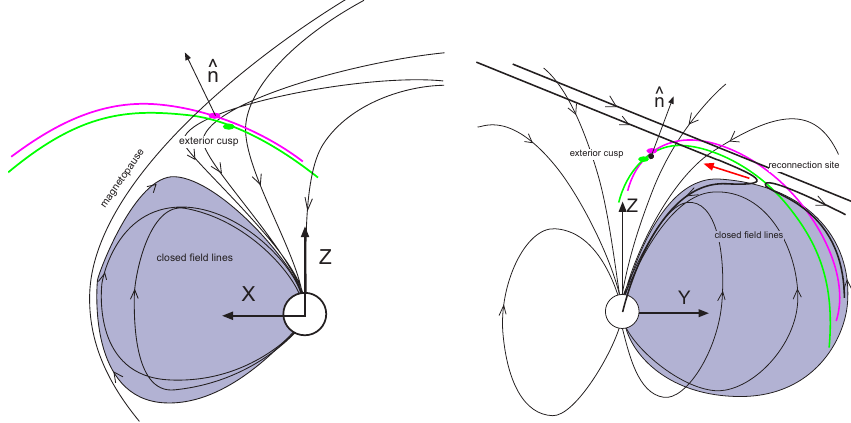
Fig. 6. Schematic diagram of Cluster 3 and 4 satellites and their orbits in the dayside magnetospheric environment. The diagram also shows the estimated boundary normal vector, IMF field lines and the antiparallel reconnection site. The red arrow shows the streaming direction of energetic particles released from the closed field lines in the